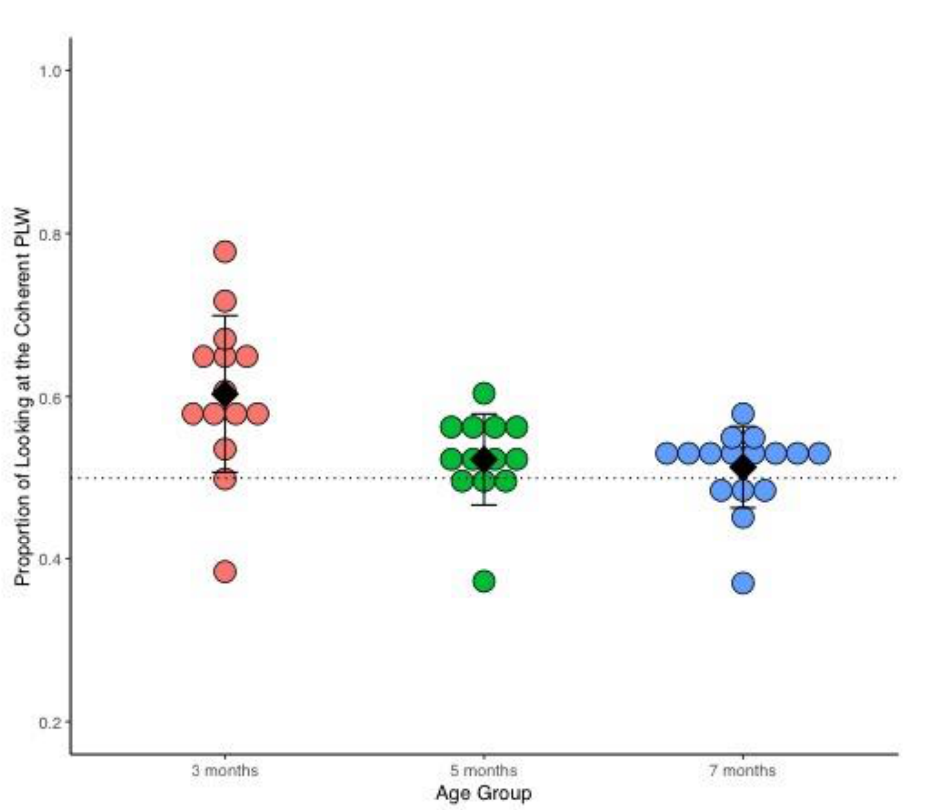
Figure 3. Proportion of looking at the coherent point-light walker (PLW) in Experiment 2 at three (red), five (green) and seven (blue) months of age. The data at three months of age are the same as the three-month-old group in Experiment 1. Each dot represents the proportion of looking at the coherent point-light walker per subject. Infants at three months of age are denoted by orange dots ( n = 14), green dots denote five months ( n = 14), and blue seven-month-olds ( n = 16). Mean group proportion per age group is represented by the black diamonds, and the black bars denote 1 +/− standard deviation of the mean. The doted horizontal line marks the 0.50 proportion, (i.e., equal looking at both stimuli) and no preference.